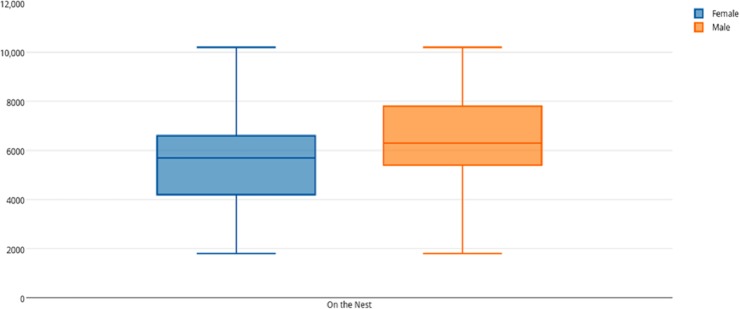
Box and whisker plot of the time spent (seconds) by flamingo partners on the nest.The horizontal lines within the box indicate the medians, boundaries of the box indicate the 25th and 75th percentile and the whiskers indicate the minimum and maximum values of the data samples. Outliers are drawn as points.